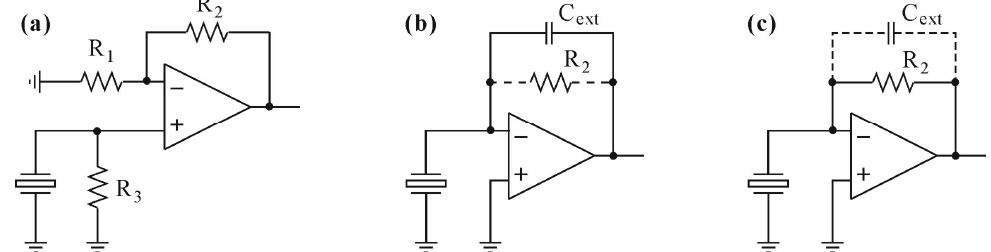
Figure 2. Basic configurations of preamplifiers dedicated for use with piezoelectric sensors: ( a ) voltage amplifier; ( b ) charge amplifier; ( c ) transimpedance amplifier. amplifier; ( b ) charge amplifier; ( c ) transimpedance